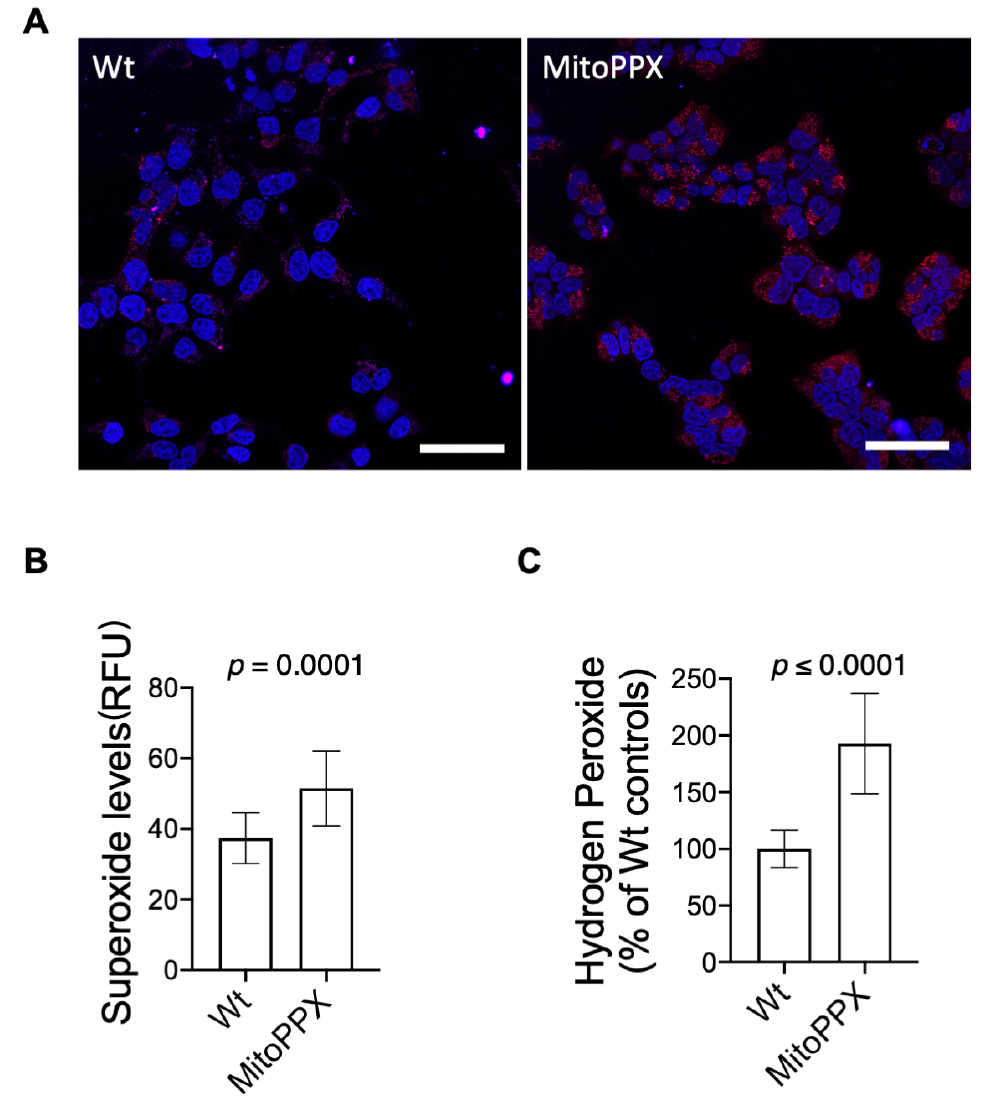
Figure 2. MitoPPX cells show increased levels of ROS. ( A ) Representative confocal images showing increased levels of O 2 − , measured by MitoSox Red, in MitoPPX cells, when compared with the Wt cells. ( B ) Quantification of the confocal images obtained after the incubation of samples with MitoSox Red. ( C ) Quantification of the fluorescence signal in Wt and MitoPPX cells after the incubation of the samples with Amplex Red to measure H 2 O 2 generation. Data in all graphs are shown as mean ± standard deviation of at least 60 fields (MitoSox Red); triplicates were obtained from at least three independent experiments. Unpaired t-tests were used to detect significant differences between Wt and MitoPPX cells. Scale bar: 200 µ M. Abbreviations used in this figure: ROS: reactive oxygen species; MitoPPX: cells expressing the exopolyphosphatase enzyme in mitochondria; Wt: Wild-type cells; O 2 − : superoxide; H 2 O 2 : hydrogen